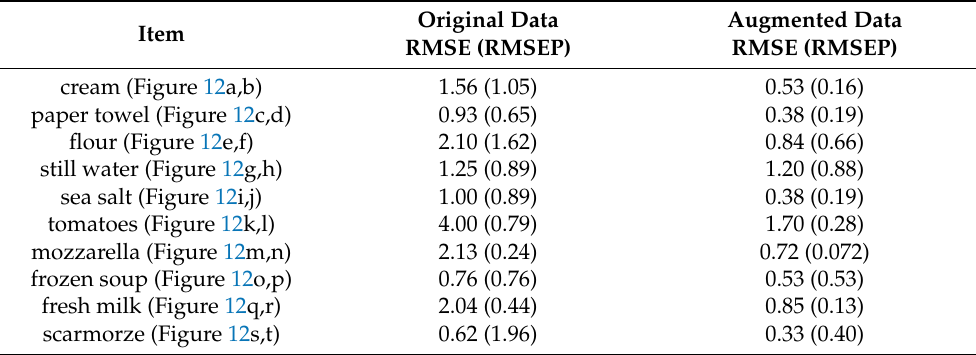
Table 4. Accuracy (RMSE and RMSEP) results of the XGBoost model when trained with original or augmented data for various items.